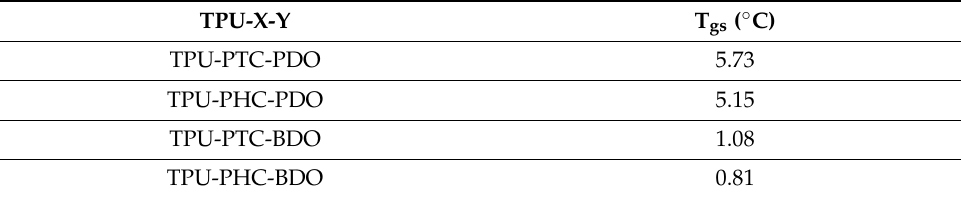
Figure 8. TPU ( a ) storage modulus curve and ( b ) tangent delta curve. Table 5. Peak of loss tangent response to the T gs of TPU.